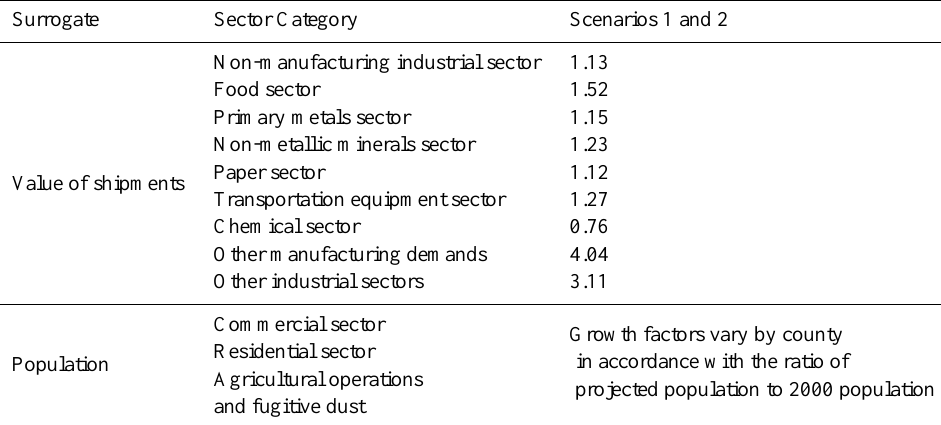
Table 4. Non-energy, surrogate-based emission growth factors, 2000 to 2050 ∗ .